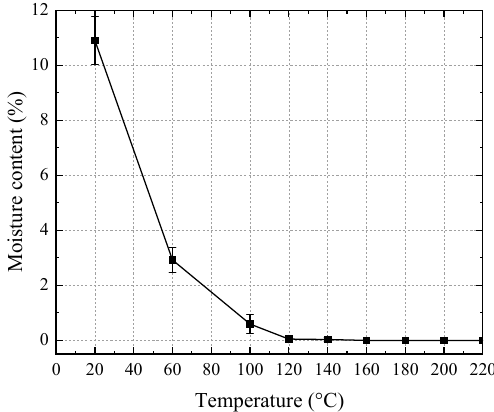
Figure 5. Temperature-dependent moisture content of the wood.